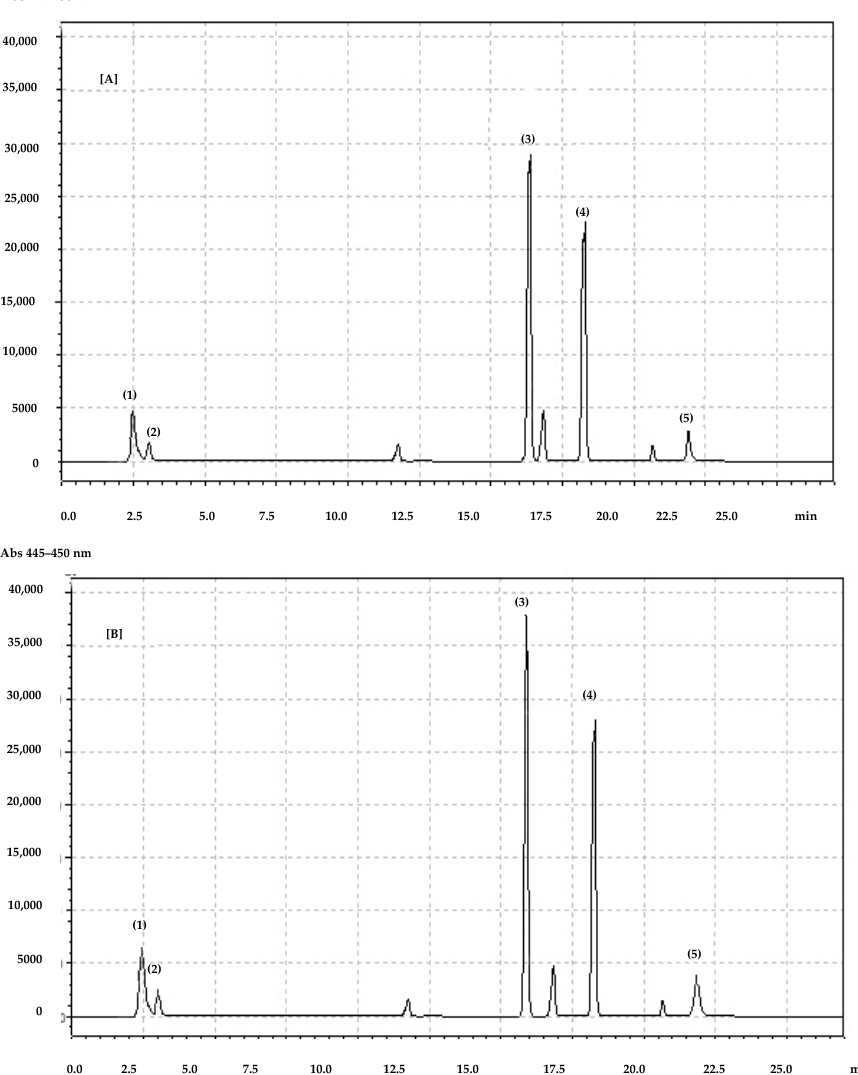
Figure 1. Chromatogram of carotenoids and chlorophylls identified in ( A ) horse chestnut and ( B ) red horse chestnut leaves. (1) lutein, (2) zeaxanthin, (3) chlorophyll b, (4) chlorophyll a, (5) beta-carotene. The last anthocyanin pigment identified in the flowers of both species was petunin- 3-O-glucoside with red horse chestnuts containing significantly more ( p < 0.0001) than occurred in horse